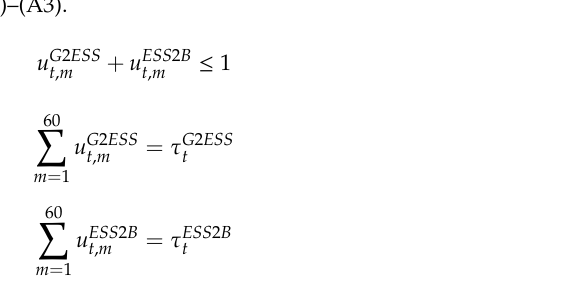
Figure A3. ESS minute operation example of 14:00–15:00, 14 August 2017.